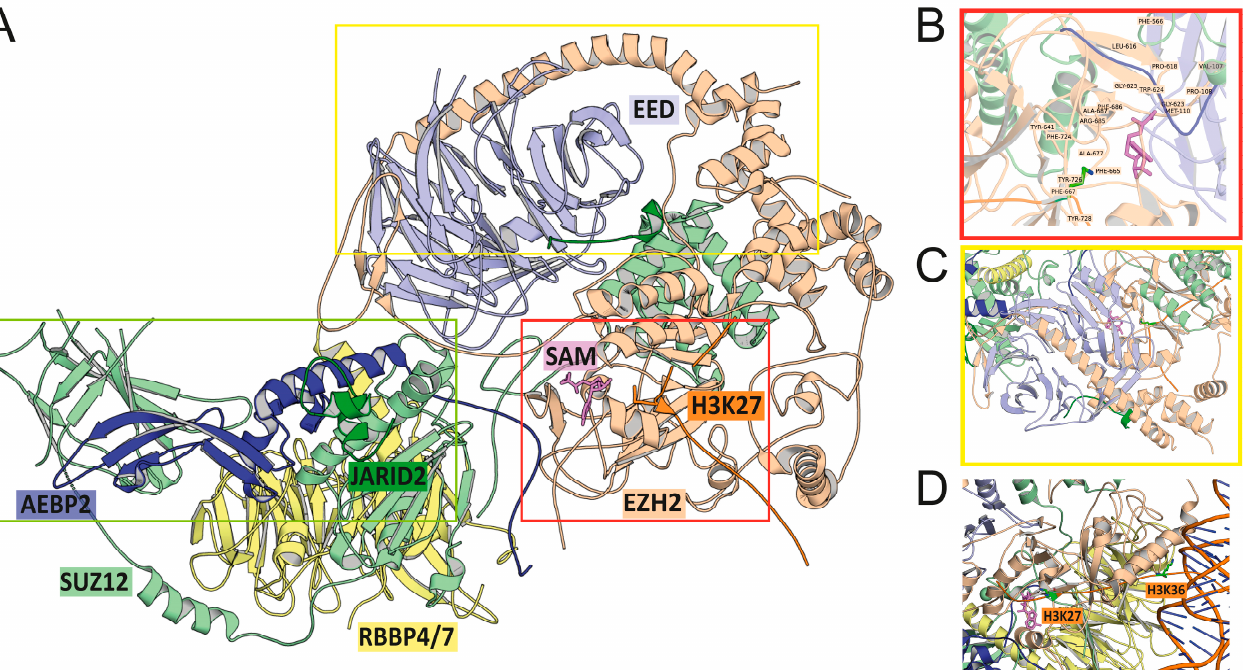
Figure 2. Crystal structure of PRC2 (PDB ID: 6WKR [31] ) showing functionally important regions. ( A ) EZH2 (beige) engages with SUZ12 (pale green), H3K27 peptide (orange) and SAM cofactor (pink) in the catalytic domain (red box) and with EED (cornflower blue) in the regulatory domain (yellow box). SUZ12 is bound to RBBP4 (pale yellow), AEBP2 (deep blue) and JARID2 (dark green) in the interaction domain (green box) that is distant from the catalytic and regulatory domains. ( B ) The histone methyltransferase site of PRC2. The cofactor SAM and long aliphatic side chain of H3K27 are stabilised by hydrophobic and aromatic amino acids from the SET domain of EZH2 (H3K37 side chain: sticks; PRC2 residues: labelled). ( C ) The regulatory domain of PRC2. EED binding domain or EBD is a long α -helix of EZH2 that wraps around the β -propeller domain of EED, forming a conformation-sensitive feedback loop for EZH1/2 activity. ( D ) Close-up of PRC2 bound to histone 3, with the two residues that are methylated on H3, i.e., H3K27 and H3K36, highlighted in green (side chains shown as sticks). PRC2 core members EED and SUZ12 are also shown alongside the SAM cofactor. Histone associated with DNA is shown on the lower right side of the panel. This figure was created using the PyMOL Molecular Graphics System v.2.5.4, Schrödinger,